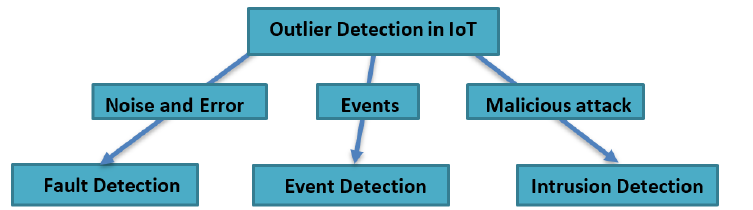
Figure 2. sources of outliers in IoTs and corresponded detection